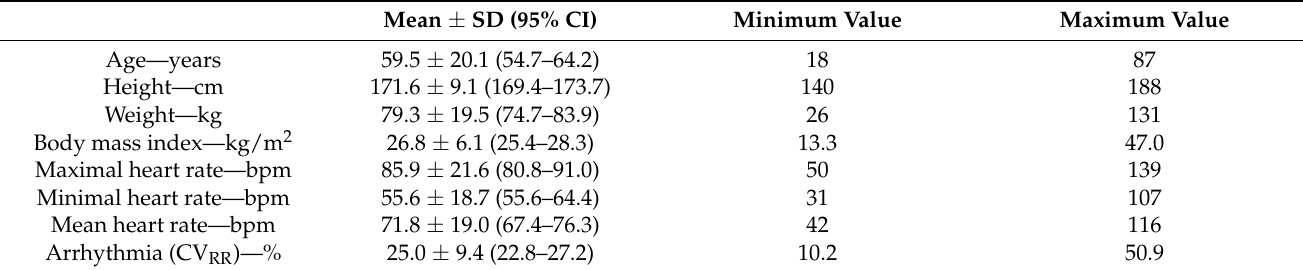
Table 3. Study population